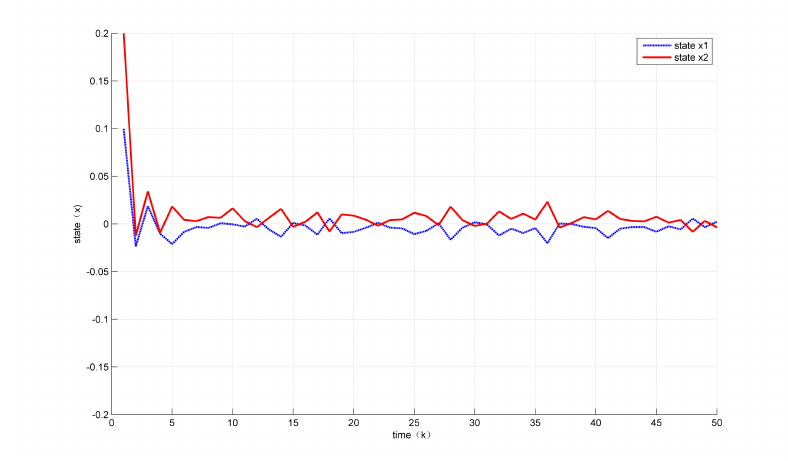
Figure 6. The state trajectories under Theorem